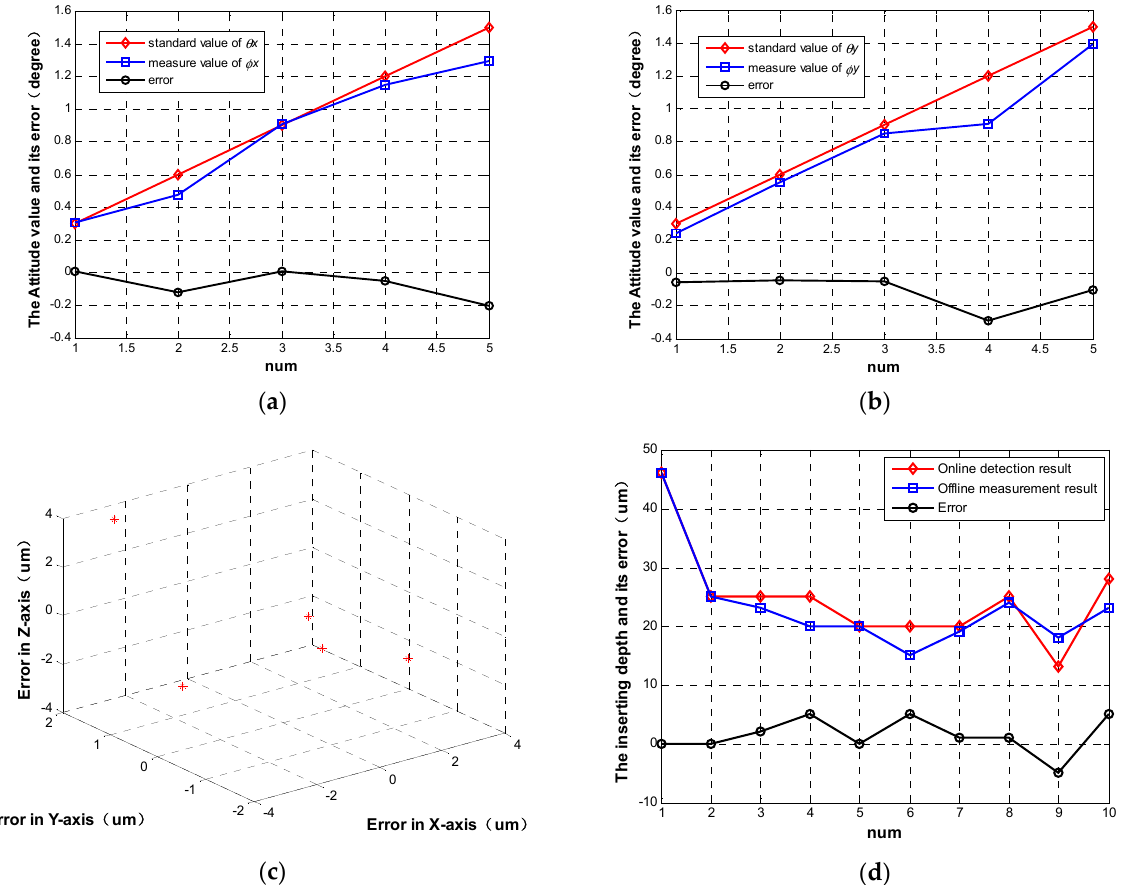
Figure 8. The results of verified experiments for posture detection: ( a ) contrast results between θ x and φ x ; ( b ) contrast results between θ y and φ y ; ( c ) result of verified experiments for position detection; ( d ) depth control error.